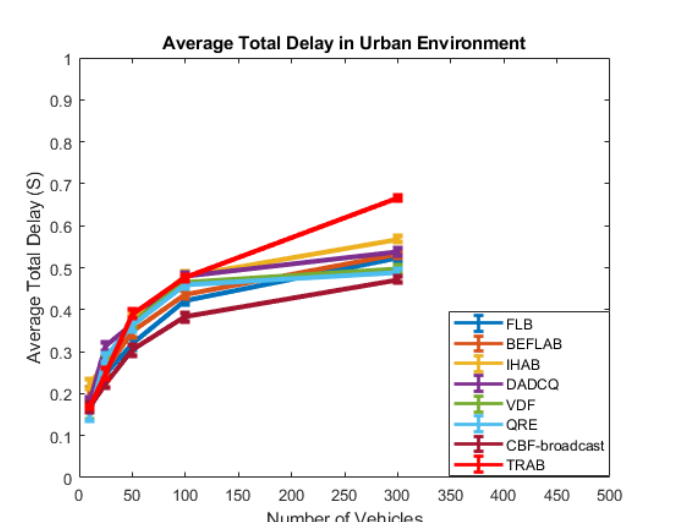
Figure 17. Urban per-hop delay.